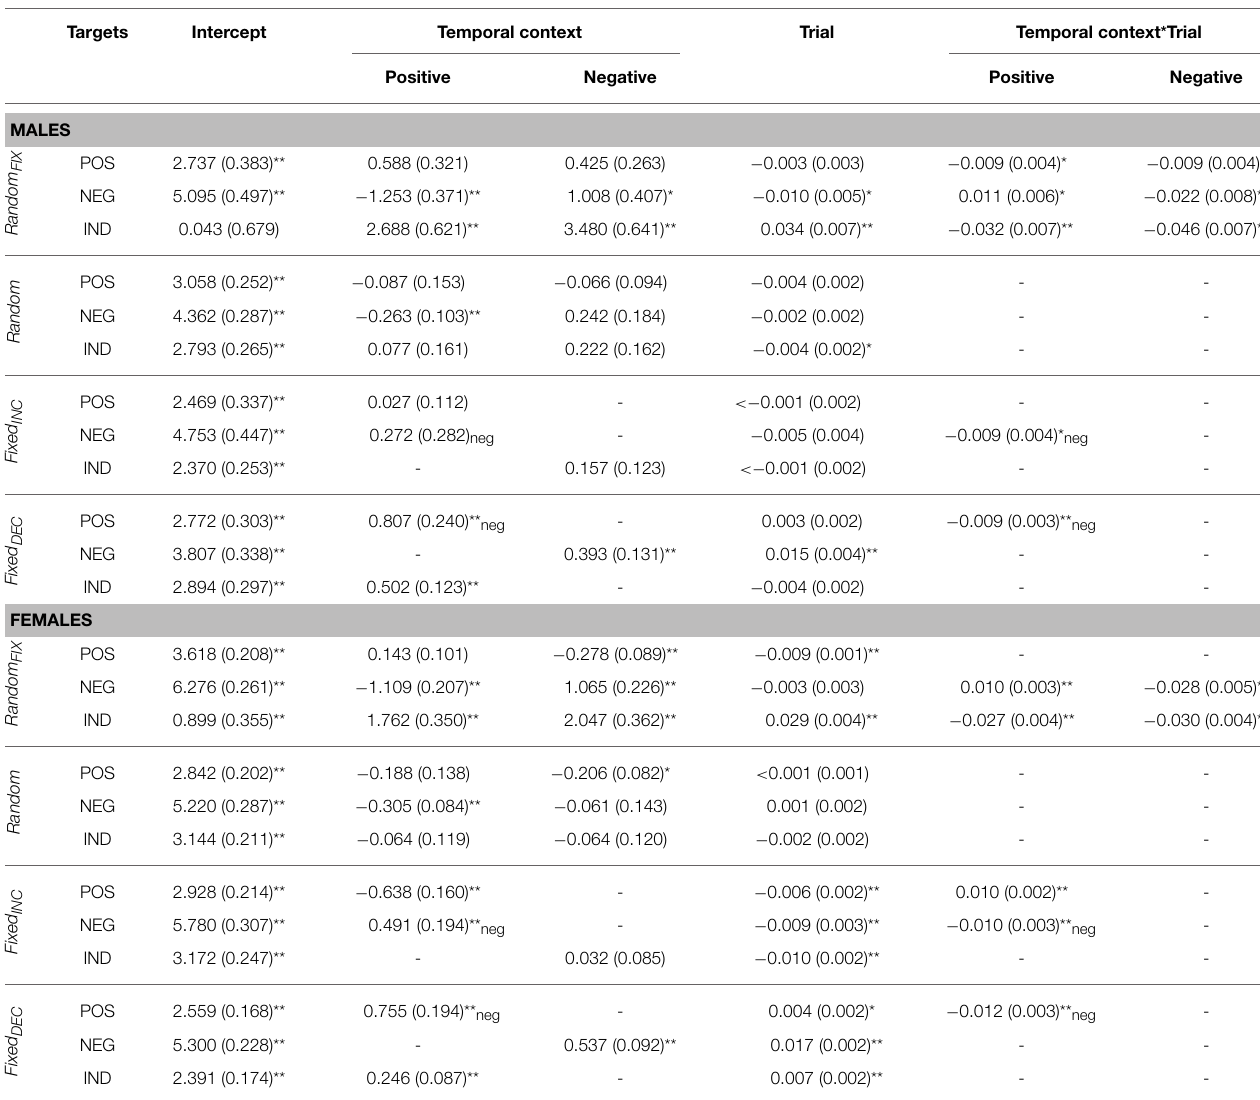
TABLE 4 | Fixed effect parameter estimates for arousal ratings according to